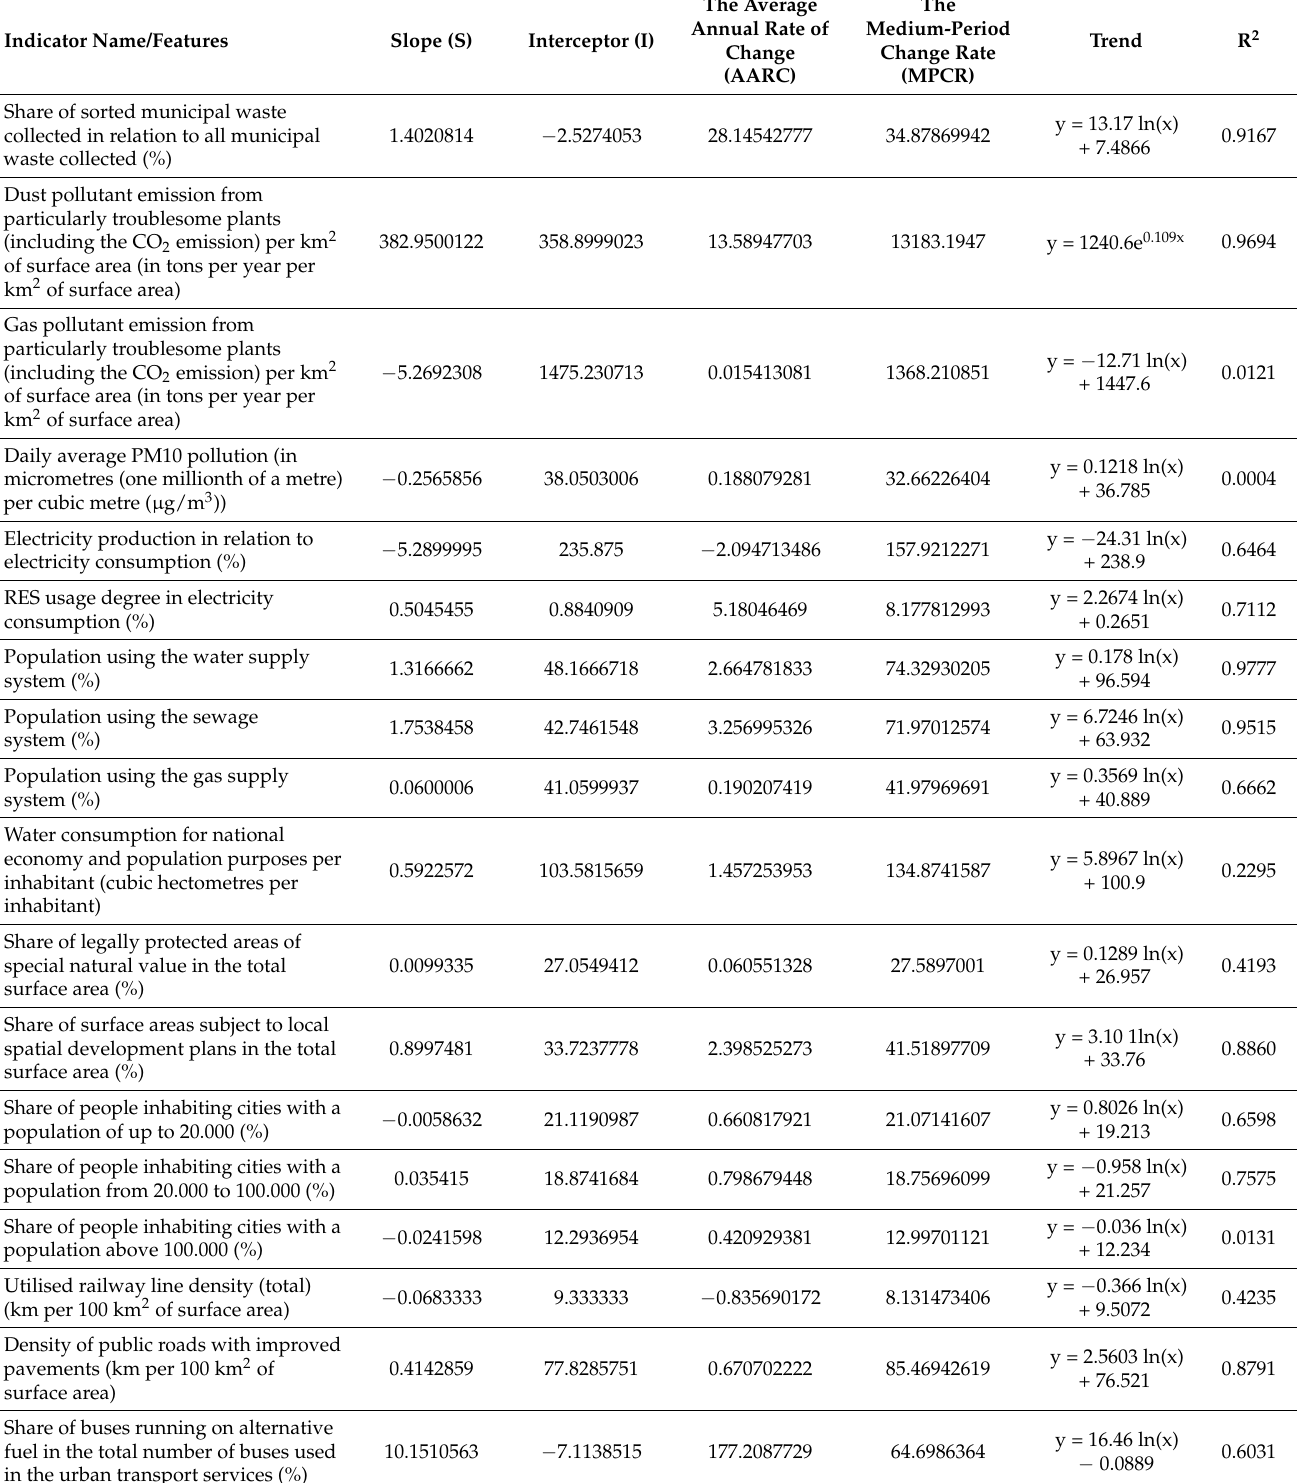
Table 3. Estimation coefficients and